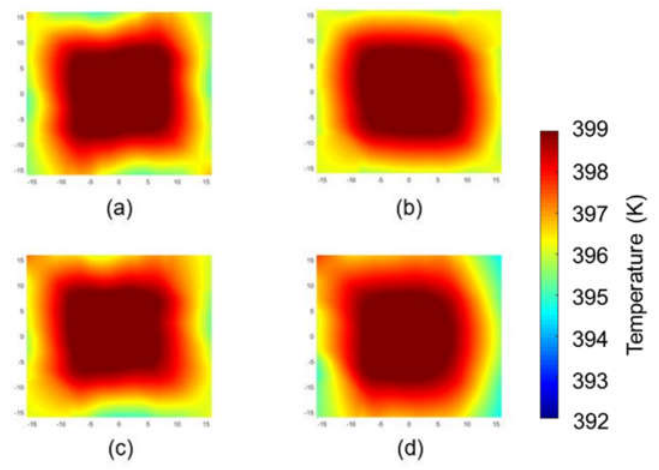
Figure 8. Temperature contour comparison among the “Inlet” conditions: ( a ) ”SS”; ( b ) “PS”; ( c ) “SC”; ( d ) ”PC”.